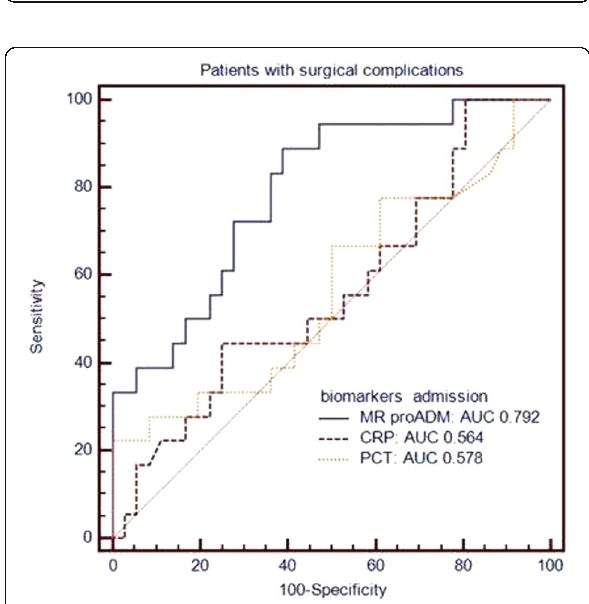
Fig. 2 (abstract 0124). Comparison of ROC curves of biomarkers to ICU admission in patients with surgical complications